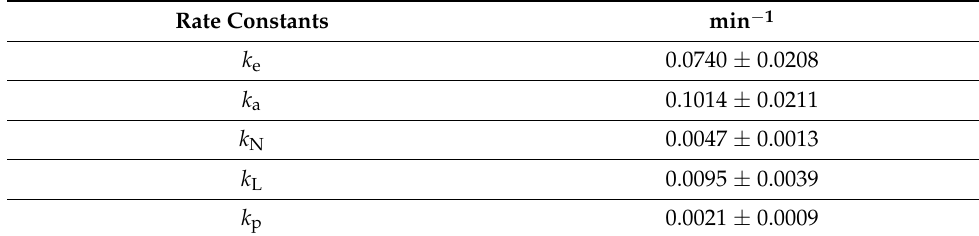
Figure 4. Pharmaceutical model CLN concentration–time curve of intranasally administered MTX fit to experimental data. Key: • , concentration in the CLN; - - - -, fitted profile. Curve fitting was performed via nonlinear regression using WinNonlin version 6.3. Data points are expressed as mean ± standard error values of at least four experiments. Abbreviations: CLN, cervical lymph node; MTX, methotrexate. Table 2. Rate constants calculated using